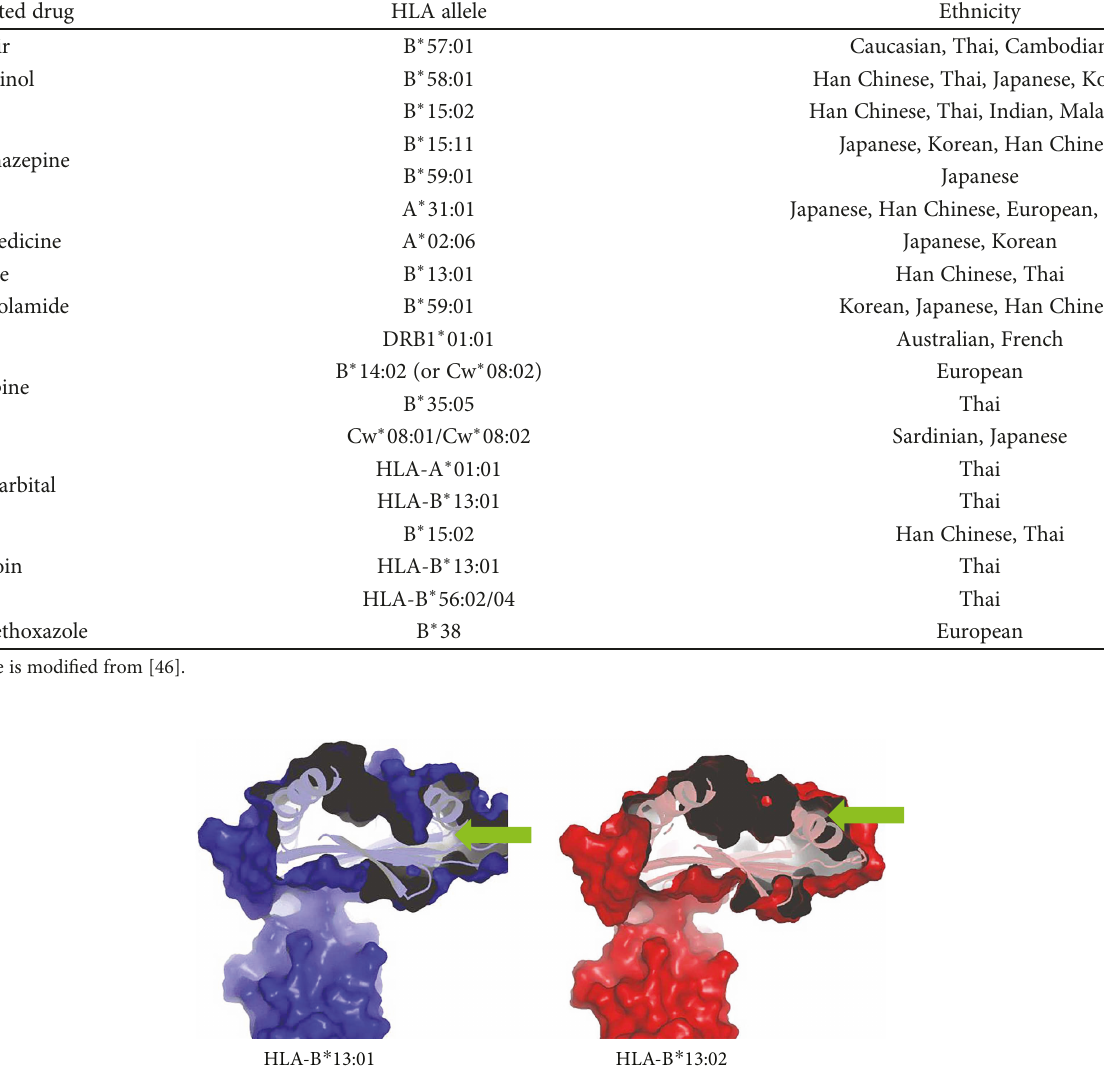
Table 2: Speci fi c human leucocyte antigen (HLA) types and associated drugs in severe drug eruptions. Associated drug HLA